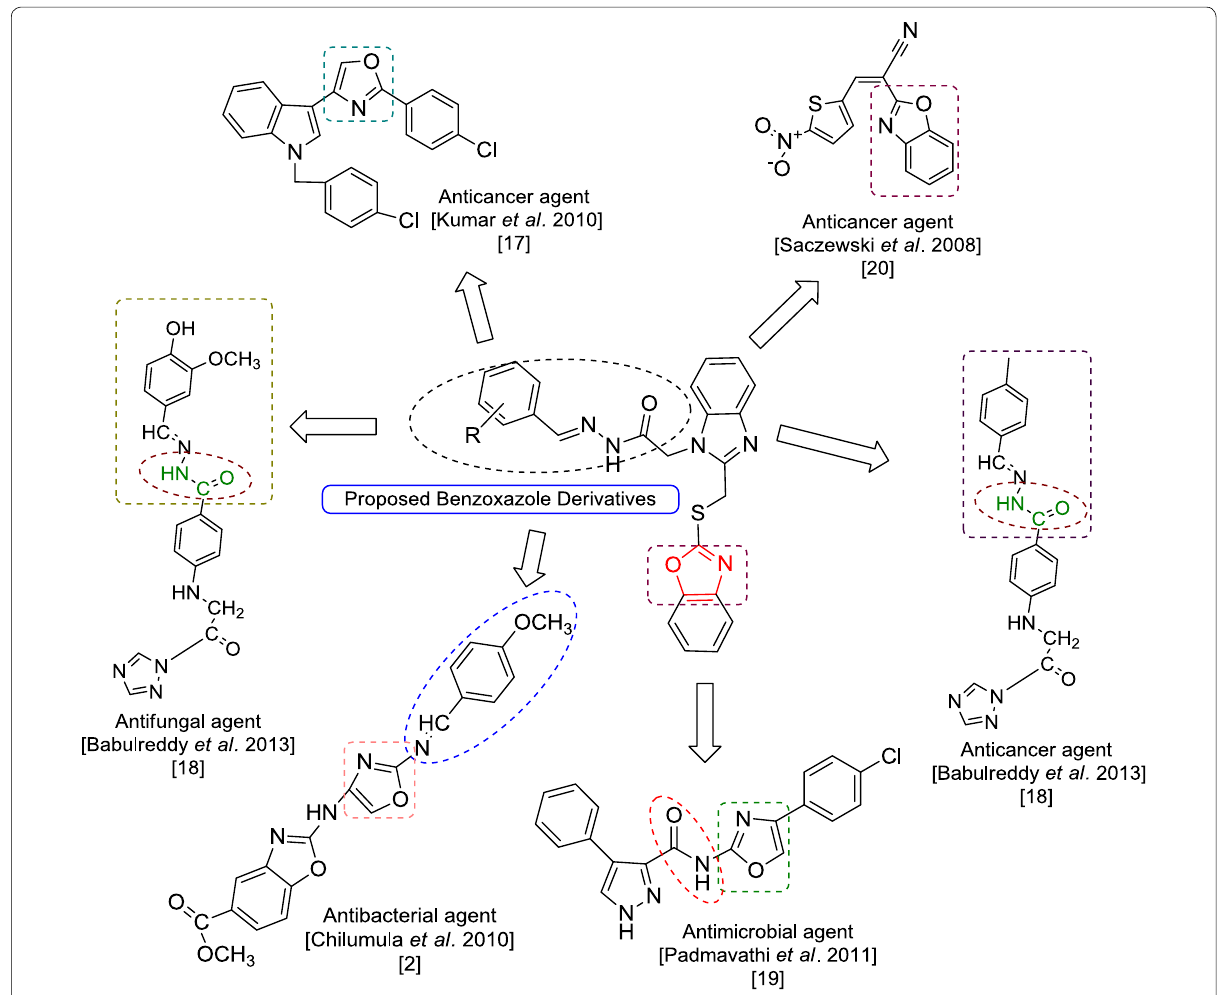
Fig. 2 Design of benzoxazole molecules for antimicrobial and anticancer potential based on